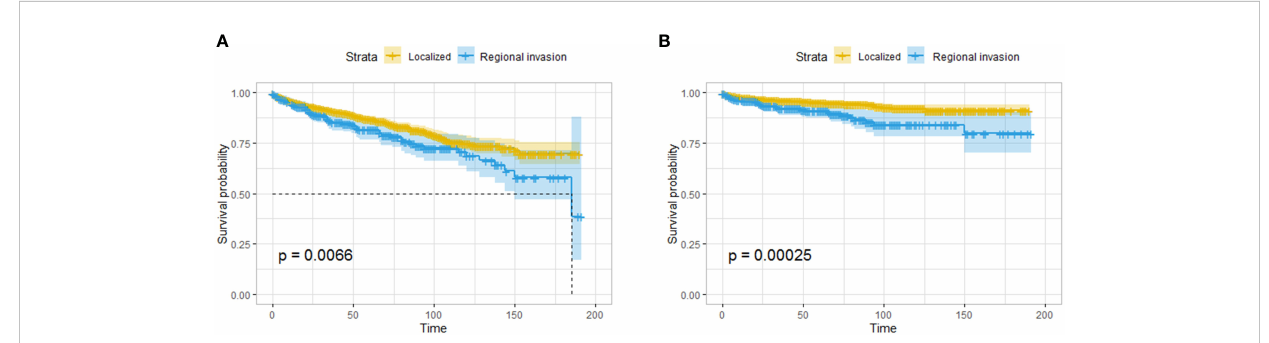
FIGURE 5 Survival analysis based on the state of regional invasion of the tumor: OS (A) and CSS (B) of all the patients. The patients with regional invasion had worse OS and CSS than those with localized